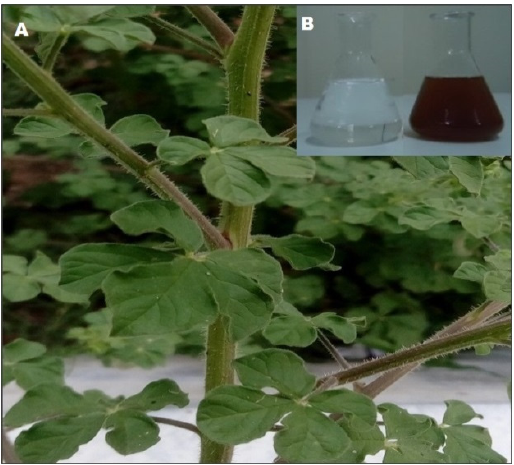
Figure 1. ( A ) Asian spider flower ( C. viscosa ) plant morphology, ( B ) Production of silver nanoparticles (AgNPs) with the development of a dark brown color designating a decrease of Ag+ into Ag 0 .